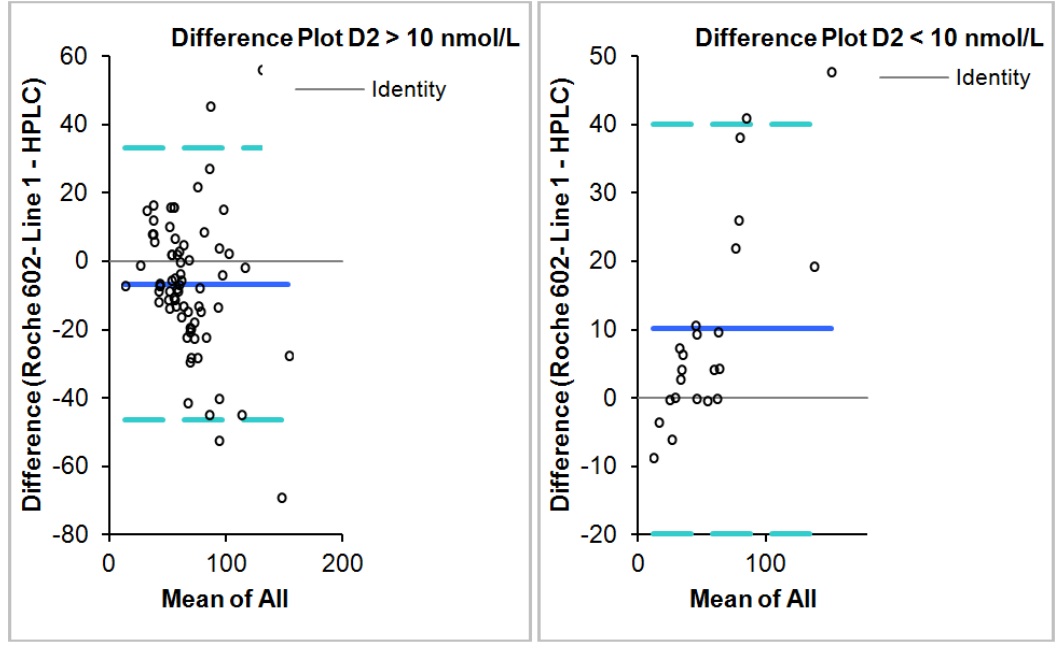
Figure 2. Bland-Altman plot showing means of paired difference between the HPLC method and the Roche Diagnostics Cobas e602 in samples with D2 greater than and less than 10 nmol/L respectively.